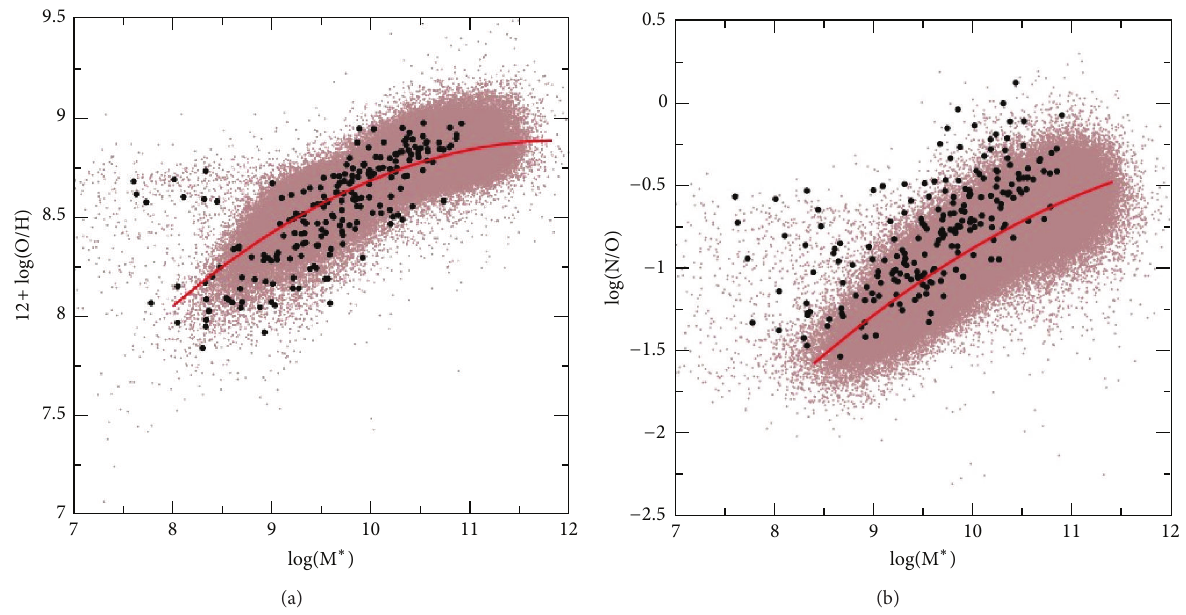
Figure 6: MZR (a) and MNOR (b) relations for the star-forming galaxies selected from the SDSS DR7. The solid red lines, calculated by P´erez-Montero et al. [55], are quadratic fits to the medians in stellar mass bins of 0.2 dex. The black points are the galaxies matching the catalog of WR galaxies by Brinchmann et al.